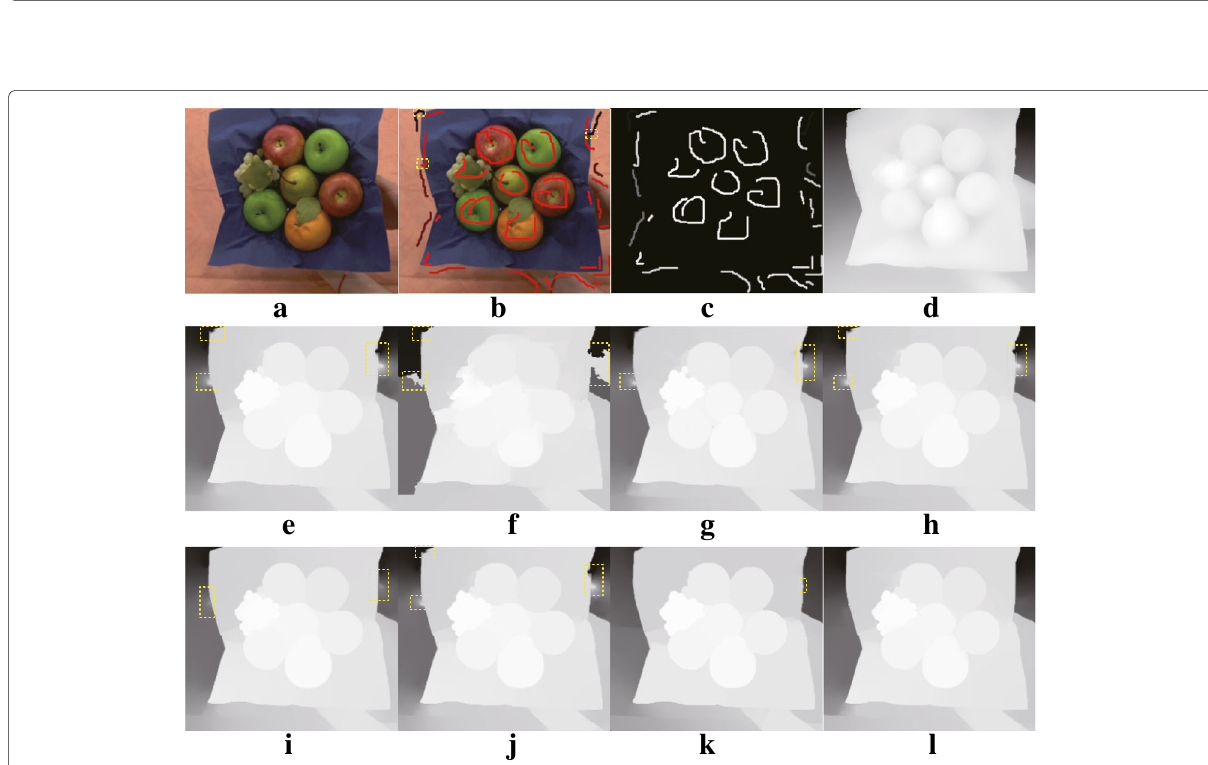
Fig. 11 Results of RGBZ_08 with cross-boundary input. a Input image. b User-labeled image. c Sparse depth. d Groundtruth depth. e Depth of RW. f Depth of HGR. g Depth of NRW. h Depth of OPT. i Depth of OCP. j Depth of SDF. k Depth of (cid:2) 1 . l Depth of the proposed method. Please zoom in to see